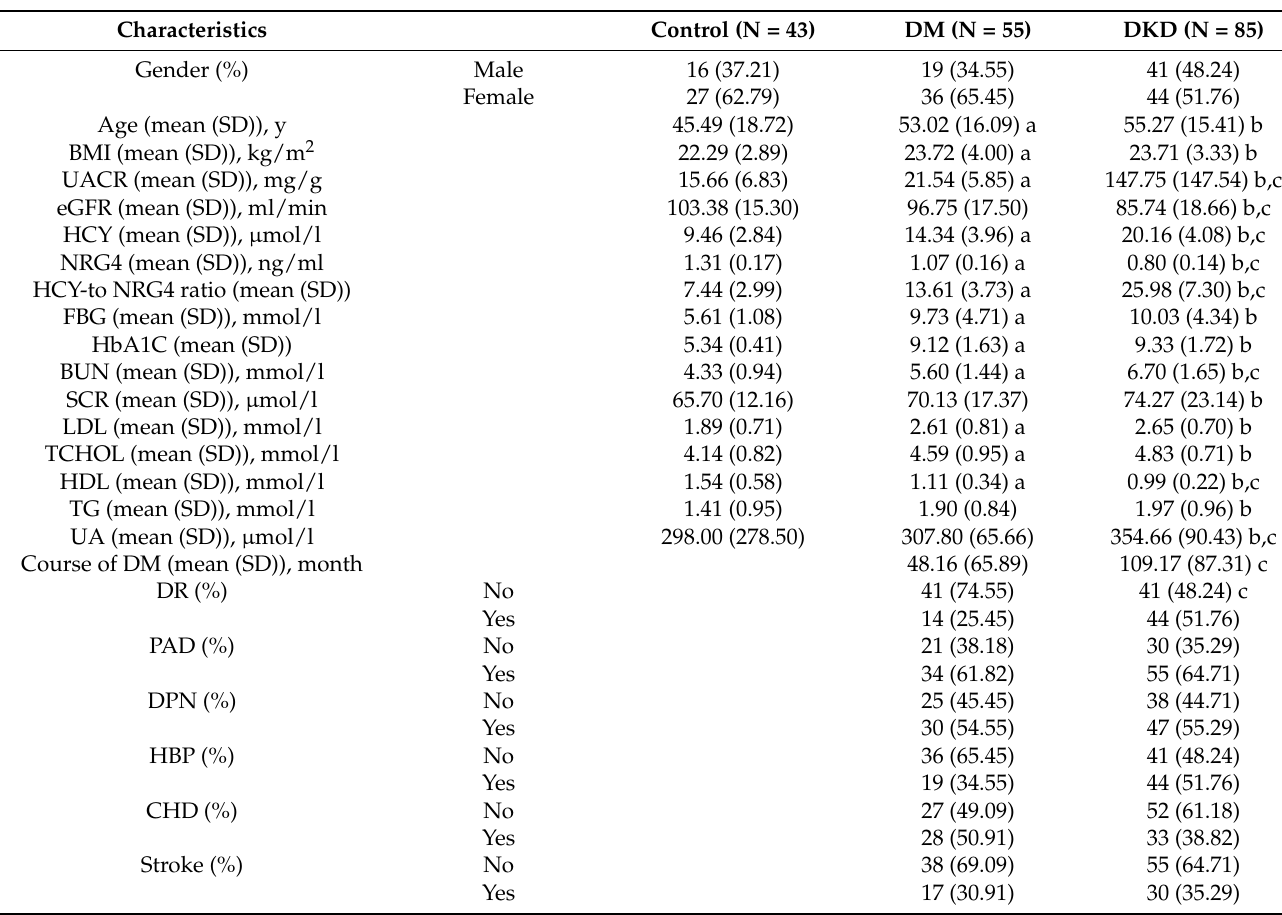
Table 1. Comparison of baseline data and laboratory test indexes among the three